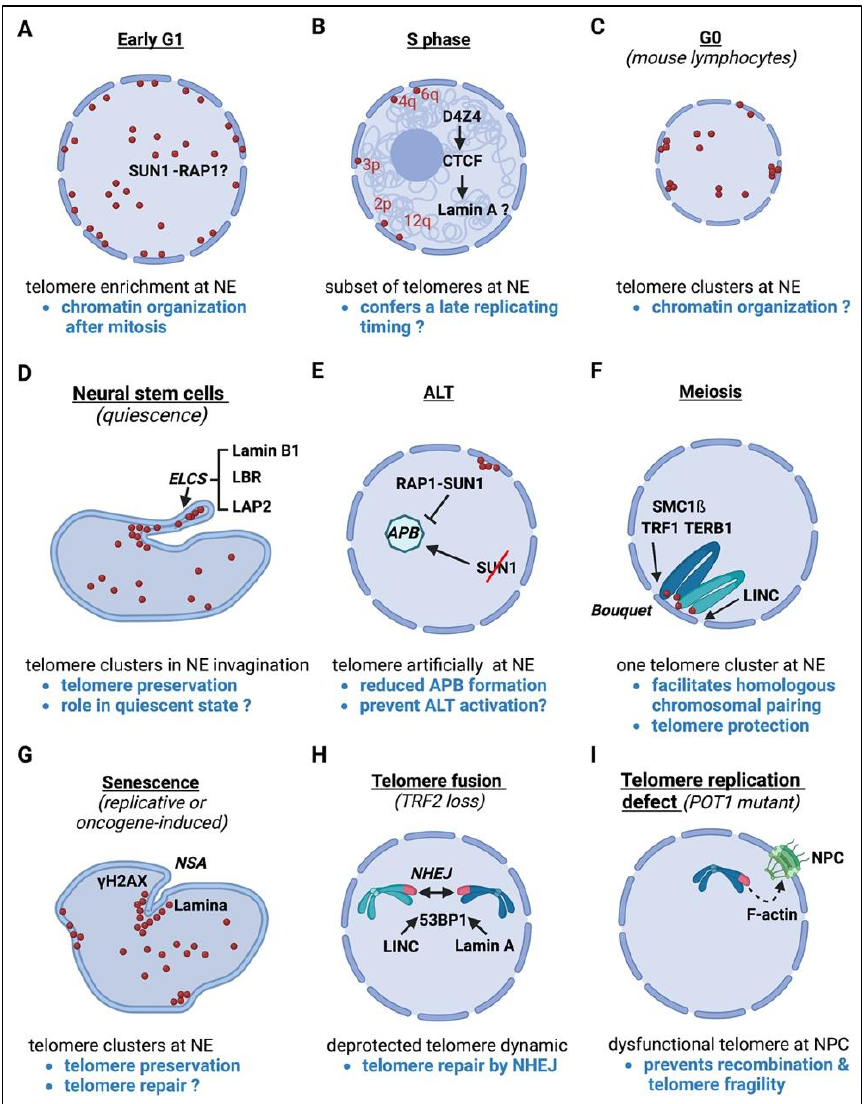
Figure 3. Summary of the different circumstances of mammalian telomere dynamics towards the nuclear envelope (NE), nuclear pore (NPC) and/or lamina. For each case, i.e., cell cycle phases: ( A – C ), cellular types: ( D – F ), and pathologic events ( G – I ), the factors involved, location of telomeres (red dots) and the potential roles of these specific telomere repositionings are indicated. NSA: nuclear shape alterations; ELCS: envelope-limited chromatin sheets; NHEJ: non-homologous end joining; ALT: Alternative Lengthening of Telomeres; APB: ALT-associated PML bodies.